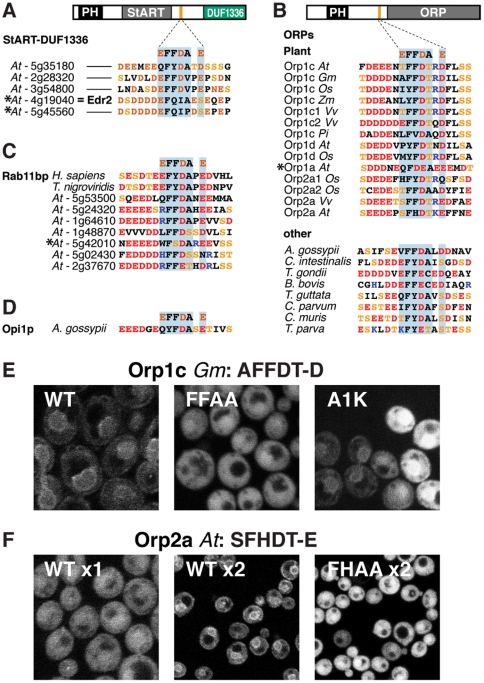
FFAT-like motifs in plant ORPs.(A–D) Aligned FFAT-like motifs from (A) the subfamily of StART proteins related to Edr2 in Arabidopsis thaliana (At); as shown in the diagram, this region is between the StART domains and DUF1336, which are domains of unknown function structurally related to galectins. (B) ORPs. FFAT-like motifs, which occur upstream of ORP domains. Top: in At and homologues in other plants: Gm – Glycine max; Os – Oryza sativa; Zm – Zea mays; Vv – Vitis vinifera; Pi – Petunia integrifolia; bottom: in other species, as listed. (C) homologues of rabphilin-11from human, fish (one each) and At (x7). These motifs are at the extreme amino-termini. (D) Opi1p in the fungus Ashbya gossypii. (E) 34 amino acids from Orp1c (Gm) including the FFAT-like motif 1AFFDT-D7 were expressed as in Figure 1A, together with variants 1AAADT-D7 and 1
KFFDT-D 7. The wild-type (WT) sequence showed moderate targeting, which was lost with 2AA3 and reduced with K1. (F) 32 amino acids from Orp2a (At) including the FFAT-like motif 1SFHDT-E7 were expressed as in (E) (left hand panel). We also expressed the dimer of this motif, and a dimer of a mutant: 1SAADT-E7 (middle and right panels, images are at 2-fold lower magnification. The wild-type (WT) monomer failed to target, but moderate targeting was obtained upon dimerization, which was lost with 2AA3.